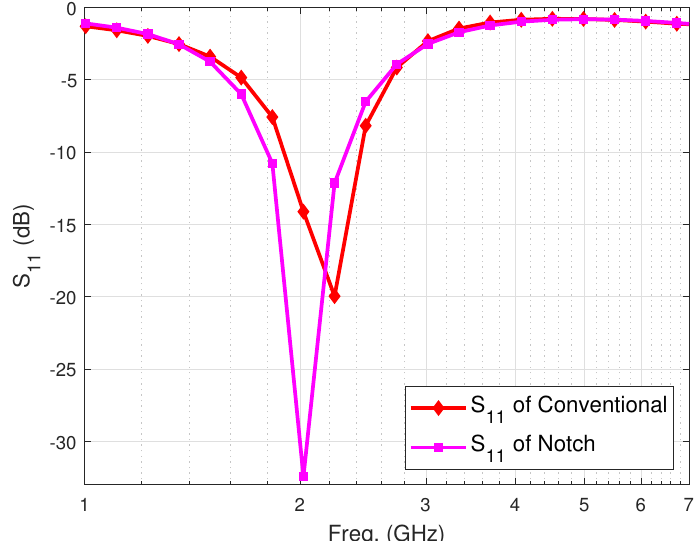
Figure 6. Input reflection (S 11 ) performance of the proposed notch LNA compared to the conventional